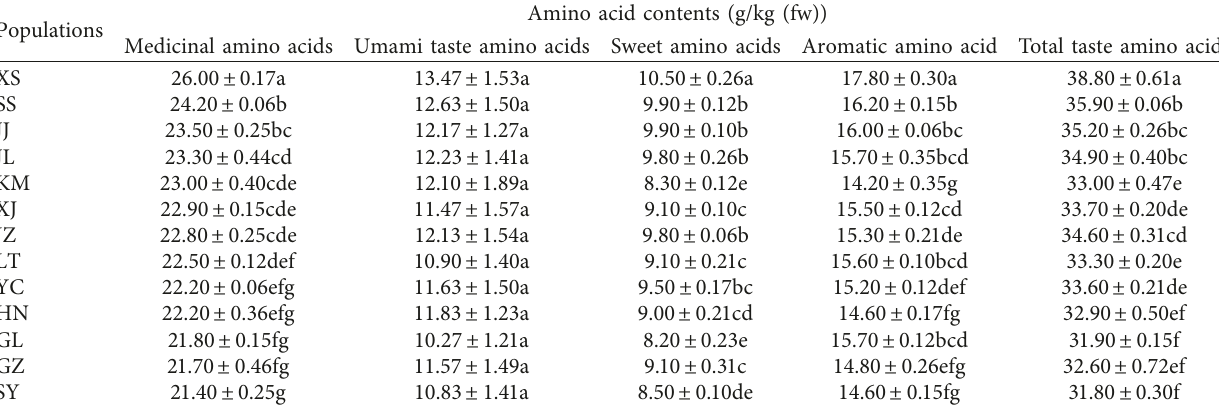
Table 2: Amino acid composition and contents of different Lycium chinense populations. Amino acid contents (g/kg Populations